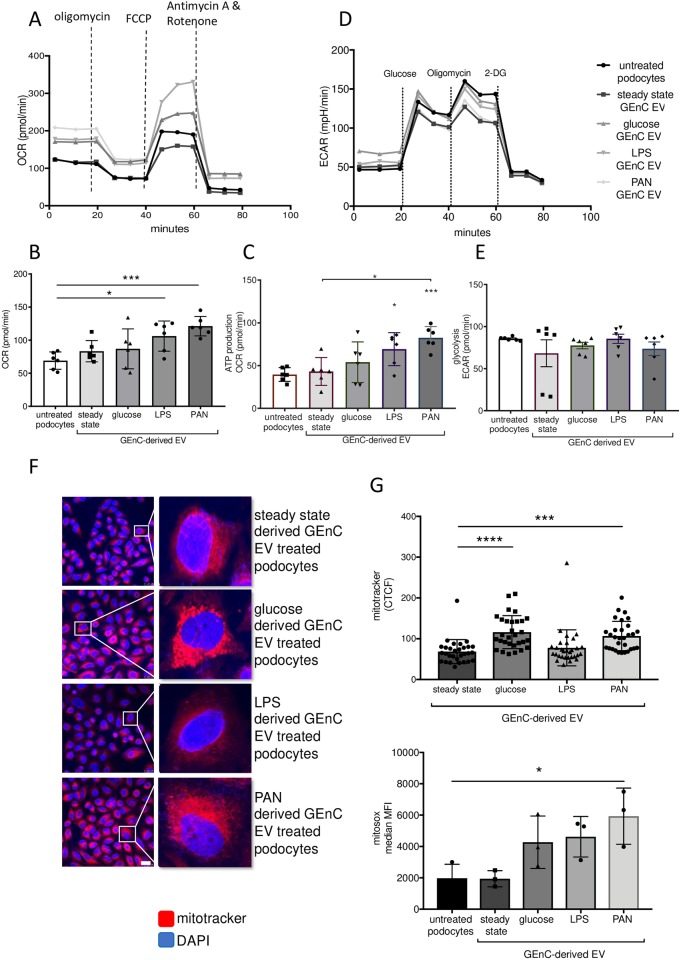
Measurement of OCR of podocytes stimulated with steady state, glucose, LPS or PAN derived GEnC EV.A) Podocytes remained untreated or were treated with steady state GEnC EV, glucose treated GEnC EV, LPS treated GEnC E or PAN treated GEnC EV for 24 hours. OCR (oxygen consumption rate) was measured in x96 seahorse extracellular flux analyser. Oligomycin (1μm), FCCP (2μM), and antimycin A/rotenone (0.5μM) were injected at indicated time points. n = 6. B) Baseline OCR for untreated podocytes or podocytes treated with steady state GEnC EV, glucose treated GEnC EV, LPS treated GEnC EV or PAN treated GEnC EV for 24 hours. n = 6. C) Baseline ATP production for untreated podocytes or podocytes treated with steady state GEnC EV, glucose treated GEnC EV, LPS treated GEnC EV or PAN treated GEnC EV for 24 hours. n = 6. D) ECAR profile over time with same treatments as in A) with injection of 1μM oligomycin and 50mM 2-deoxyglucose (2- DG) as indicated. n = 6. E) Glycoloysis measurements at baseline after podocoyte treatments with EV or at baseline. n = 6. F) Representative images of mitochondrial activity using 100nM MitoTracker (red) and nuclei counterstained with DAPI (blue) detected with fluorescence microscopy. Scale bar = 25 μm. G) Quantitative mitochondrial activation with 100nM MitoTracker after podocyte incubation with EV from steady state GEnC, glucose treated GEnC, LPS treated GEnC or PAN treated GEnC. Each dot represents 1 mitochondrion from n = 3 experiments. H) Flow cytometry measuring podocyte intracellular ROS levels using 5μM mitoSOX after podocyte incubation with EV from steady state GEnC, glucose treated GEnC, LPS treated GEnC or PAN treated GEnC. n = 3. *, ***, **** represents P<0.05, P<0.001 or P<0.0001 respectively, groups were compared using a one-way Anova.